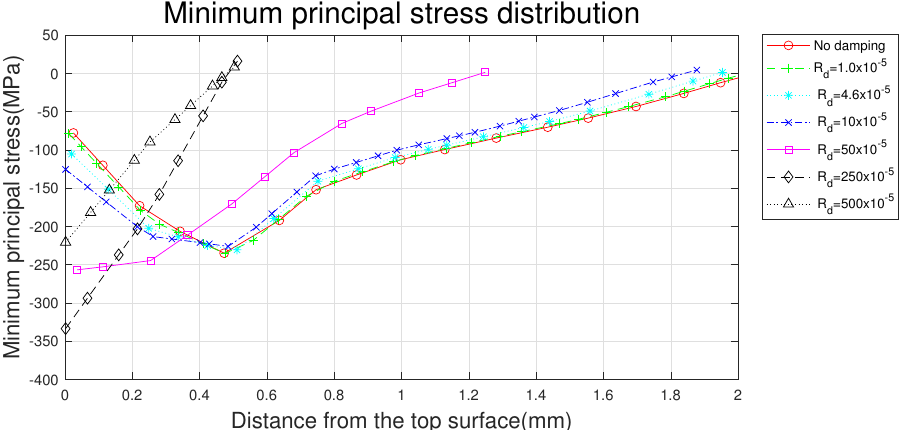
Figure 12. Minimum principal stress of single LSP FE solution in the depth (z-) direction at the center of the pressure load